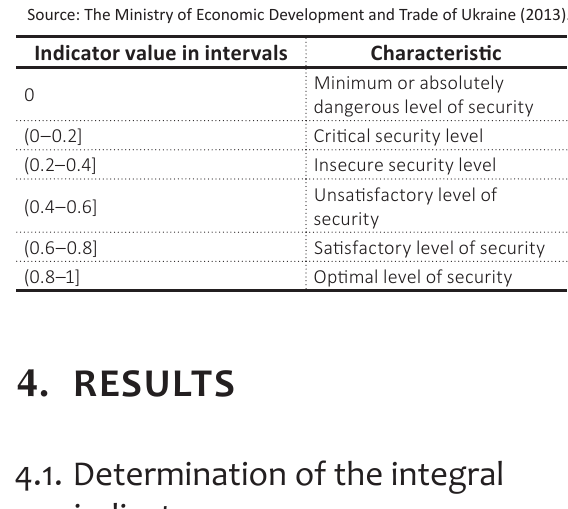
Table 1. Criteria for a qualitative assessment of Ukrainian banking sector’s financial security